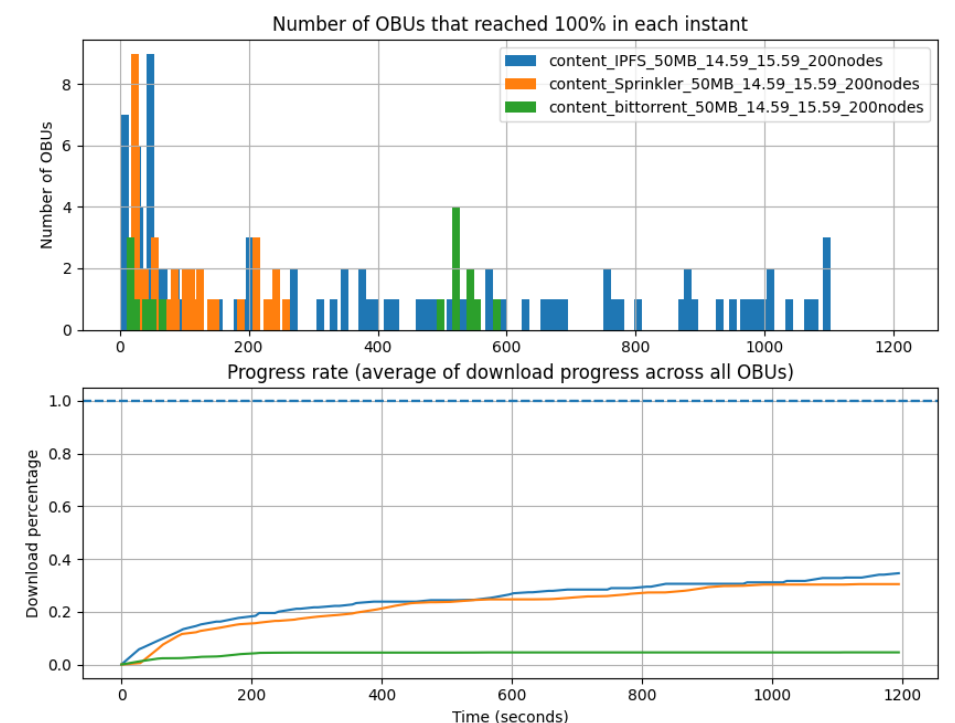
Figure 15. Comparison between IPFS (blue), BitTorrent (green) and Sprinkler (orange) with a 50 MB file being distributed through 200 nodes in Oporto from 15 h to 15:20